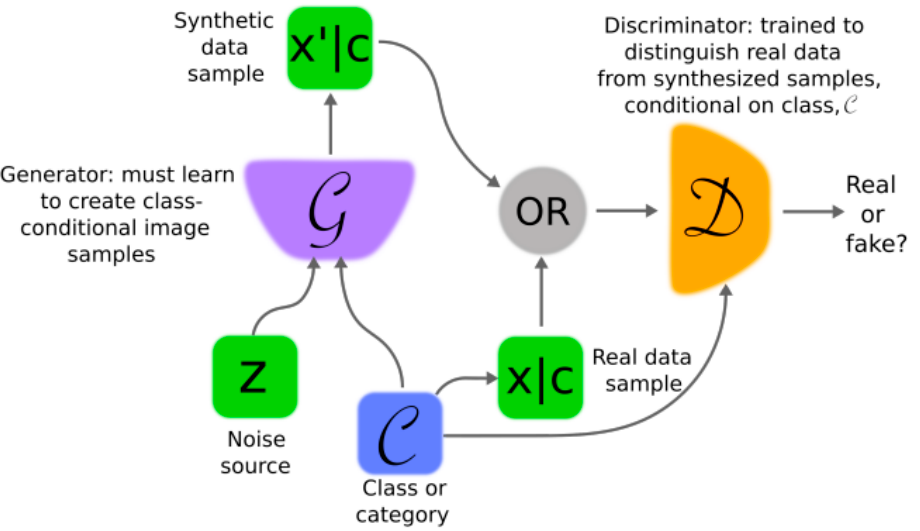
Figure 1. The architecture of a conditional GAN. A conditional GAN has two DNNs: a generator G and a discriminator D . The generator creates the conditional image synthesis, and the discriminator calculates the conditional distance between the generated objects and the real ones.